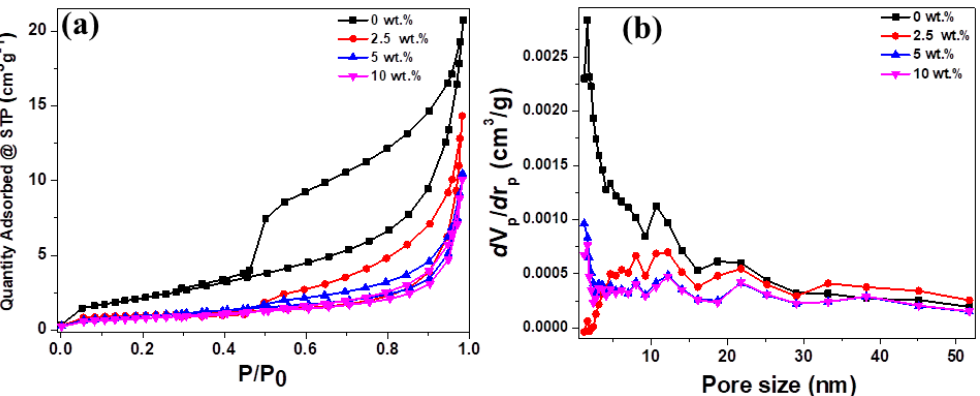
Figure 4. ( a ) N 2 adsorption / desorption isotherms and ( b ) pore-size distribution plots for the as-synthesized h BN samples annealed at 1200 °C after addition of 0–10 wt.% of BaF 2 .